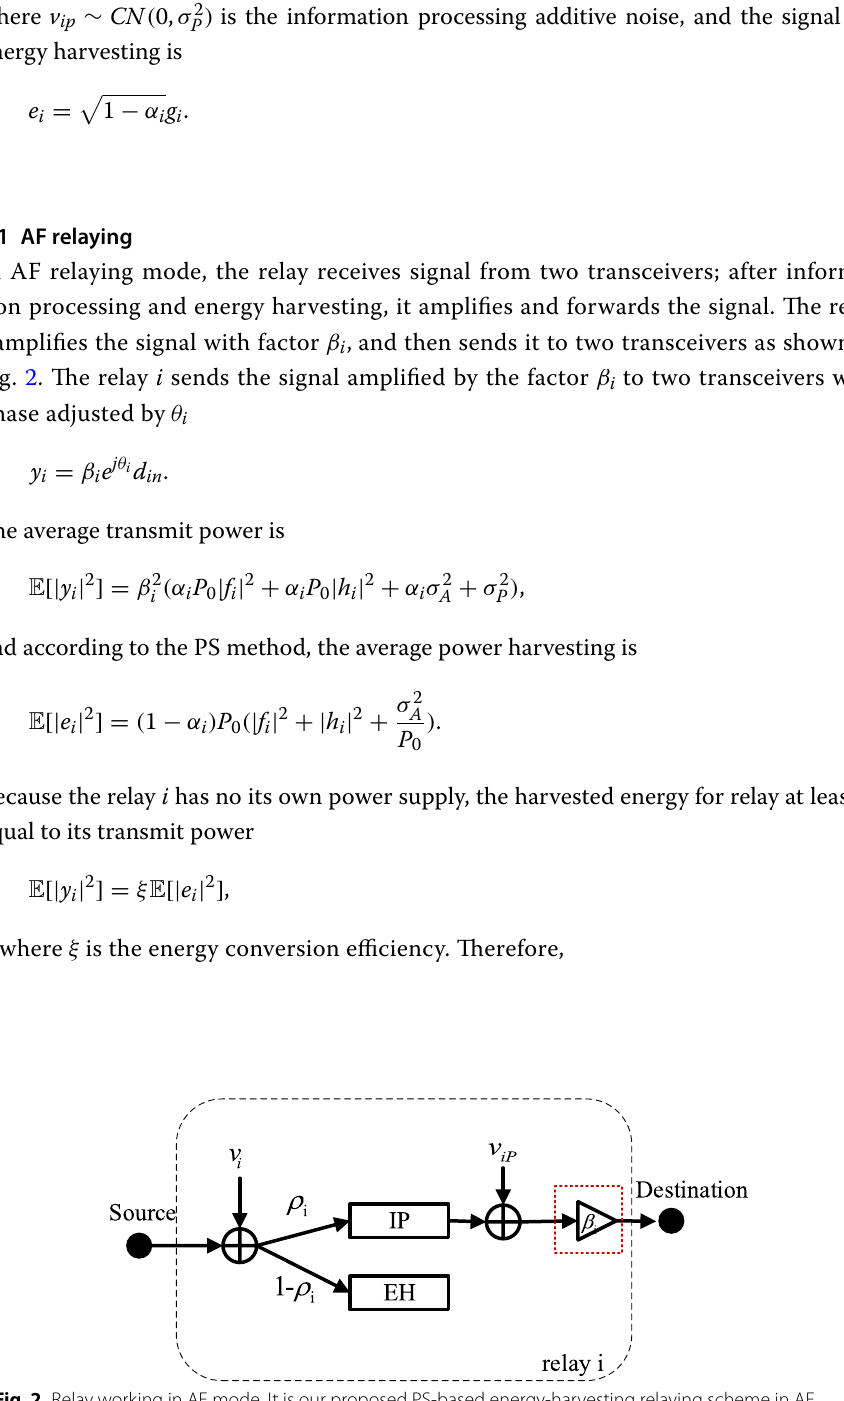
Fig. 2 Relay working in AF mode. It is our proposed PS-based energy-harvesting relaying scheme in AF